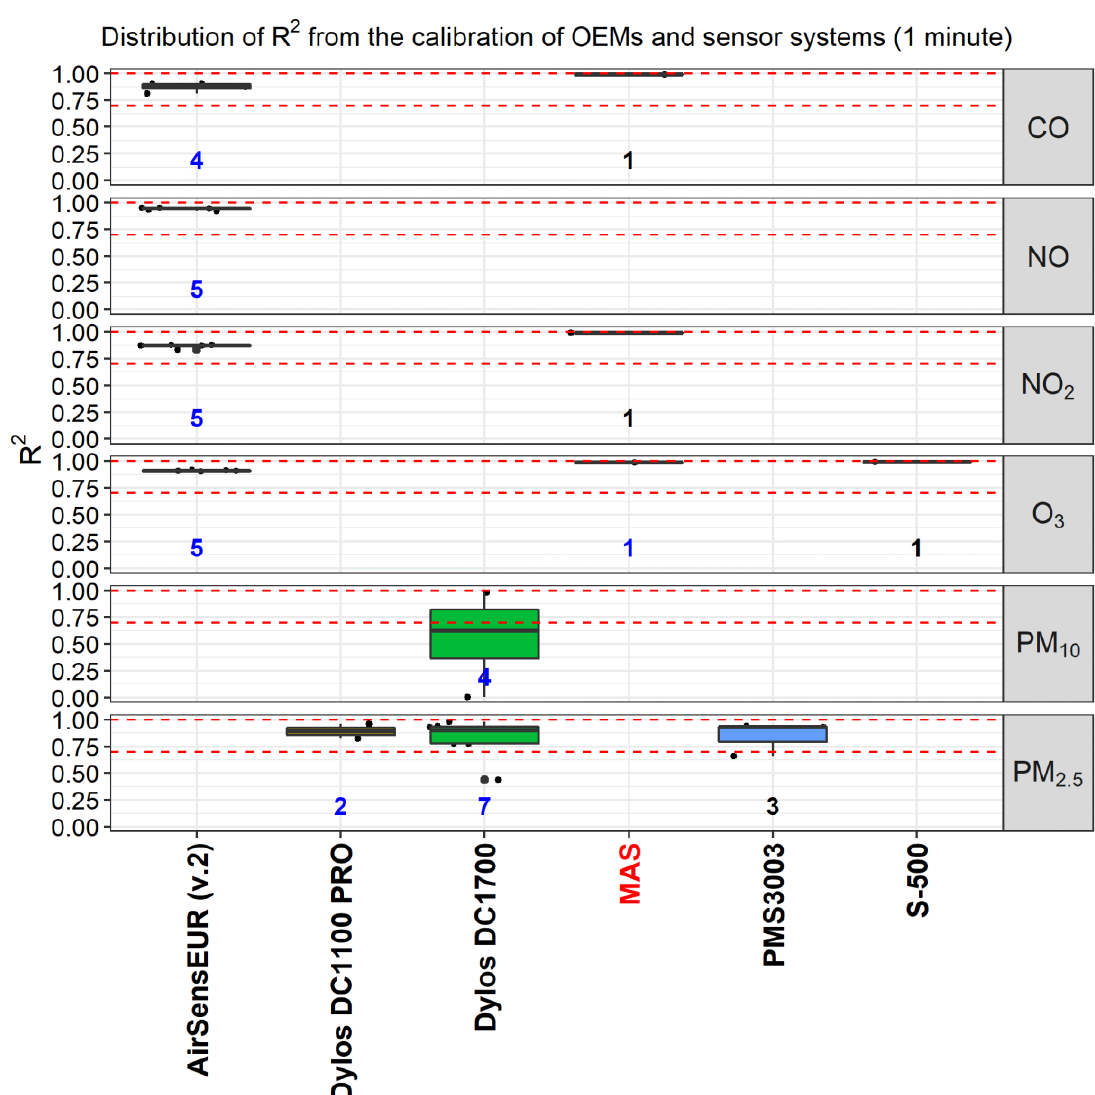
Figure A2. Distribution of R 2 for LCS minute data against the reference for different pollutants. Dashed lines indicate the R² value of 0.7 and 1.0. Numbers in blue and black indicate the number of open source and black box records, respectively. Names of “ living ” and “ non-living ” sensors are indicated in black and red labels of the x-axis color, respectively.